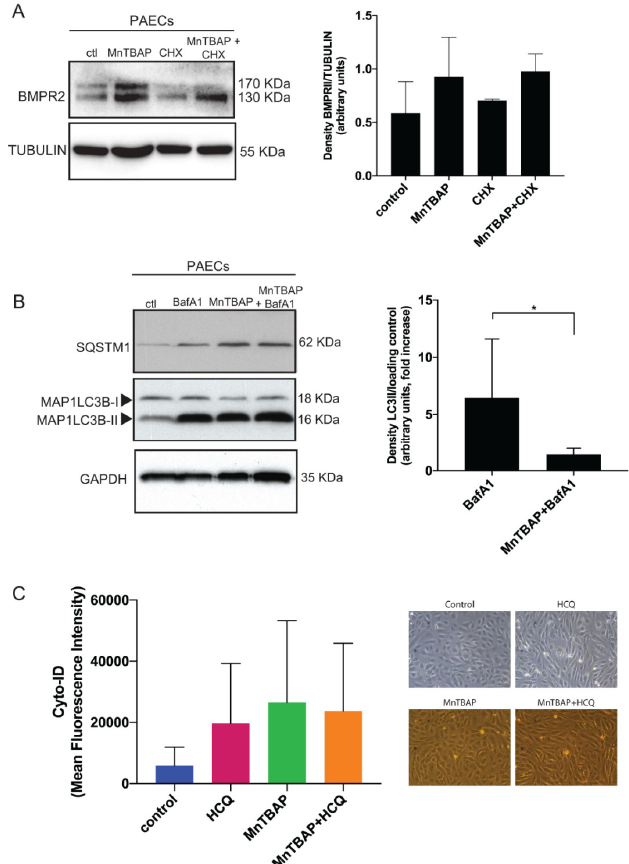
Figure 2. MnTBAP inhibits BMPR2 degradation by blocking autophagy. ( A ) MnTBAP restores inhibitory effects of cyclohexamide (CHX) on BMPR2 protein expression. PAECs were treated with MnTBAP (50 µM) for 16 h, cycloheximide for 2 h and the combination. BMPR2 protein expression was analyzed by western blot. Tubulin is used as a loading control. Representative results of at least 3 independent experiments are shown. ( B ) PAECs were treated with MnTBAP (50 µM) in the presence or absence of BafA1 (20 nM) for 16 h and lysed directly after the treatment. Left panel: MAP1LC3B-II protein levels were analyzed by western blot. Glyceraldehyde-3-phosphate dehydrogenase (GAPDH) is used as a loading control. Representative results of at least 3 independent experiments are shown. Right panel: Western blot quantification of MAP1LC3B-II normalized for the loading control. The data are presented as fold increases relative to cells treated with BafA1. ( C ) Left panel: Flow cytometry-based analysis of the quantification of autophagic vesicle content in PAECs by means of the Cyto-ID dye. Cells treated with MnTBAP (50 µM) for 16 h with and without hydroxychloroquine (HCQ) (20 µM) and analyzed directly after the treatment. Right panel: Representative light microscopy images of PAECs treated for 16 h with MnTBAP (50 µM), HCQ (20 µM) and the combination, to show the status of the cells after MnTBAP treatment. Upper panels, bright field images; lower panels, fluorescent images. Magnification: ×20. Data presented as mean ± SD. * p < 0.05.